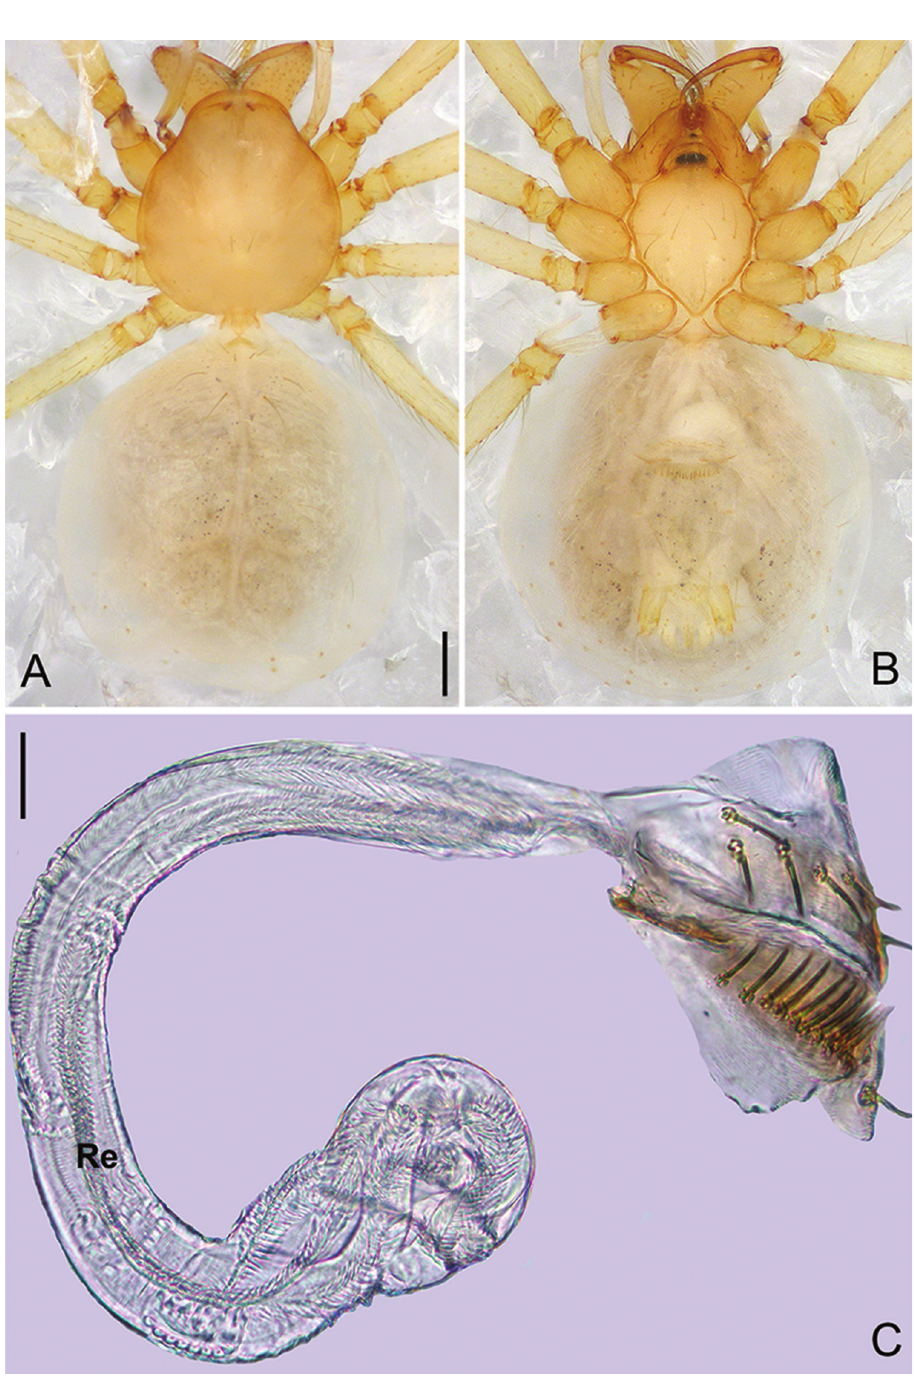
Figure 11. Pinelema liangxi , female. A Habitus, dorsal view B Habitus, ventral view C Endogyne, lateral view. Scale bars: 0.2 mm ( A–B ), 0.05 mm ( C